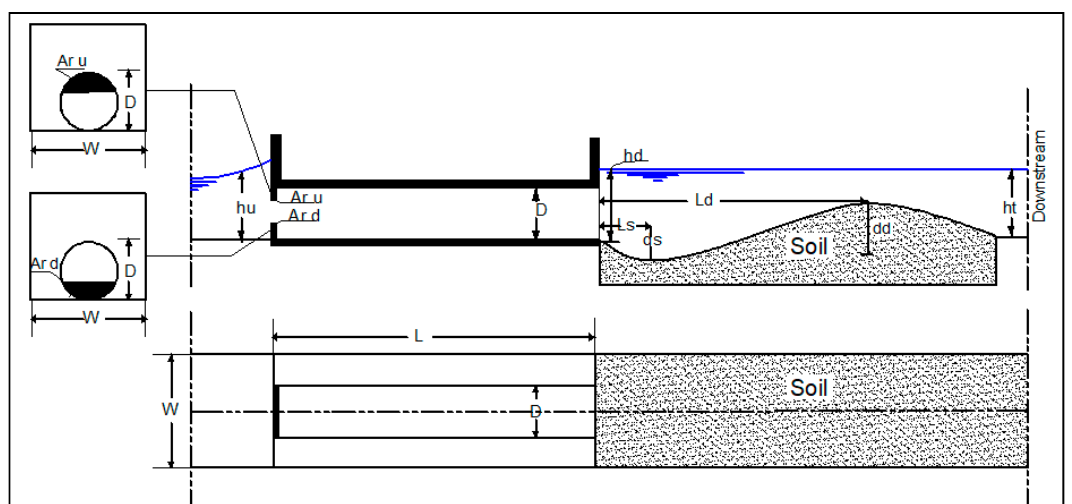
Figure 1. Definition sketch of model elevation and plan.